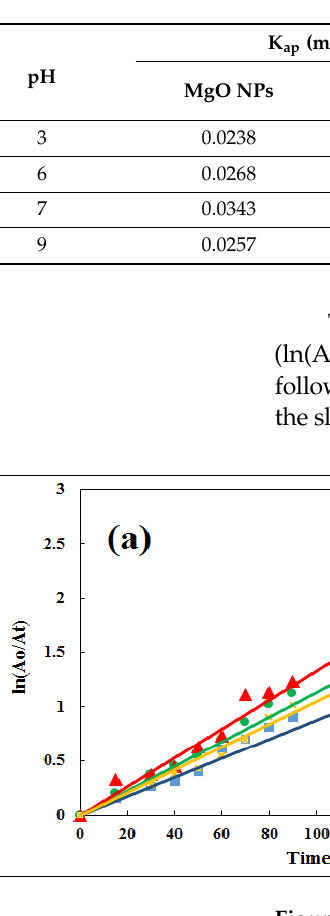
Figure 11. Plot of ln (A 0 /A t ) versus reaction time, t, at different pH values under the experimental conditions using ( a ) 0.20 g MgO NPs and ( b ) 0.15 g MgO/Ben